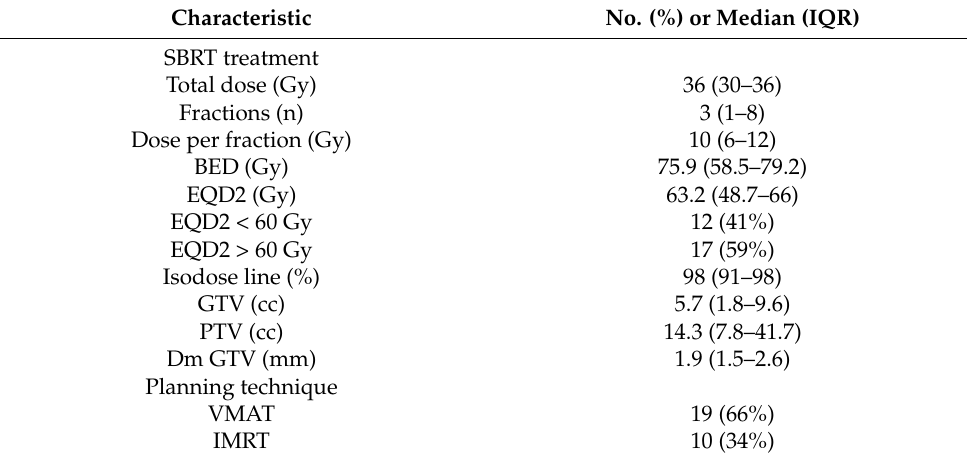
Table 2. Dosimetric characteristics.